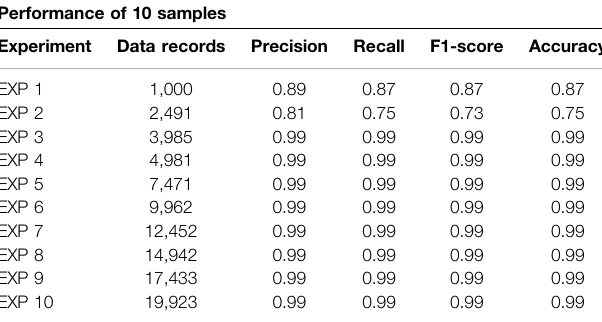
TABLE 1 | SGD MLS model on the MEC server. Performance of the MLS model. Accuracy: 0.99